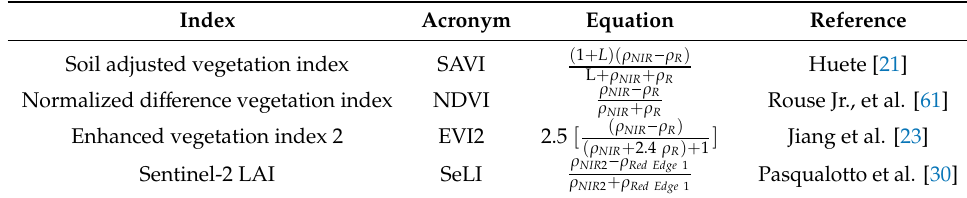
Table 2. References and equations of selected VIs to be evaluated in this study.